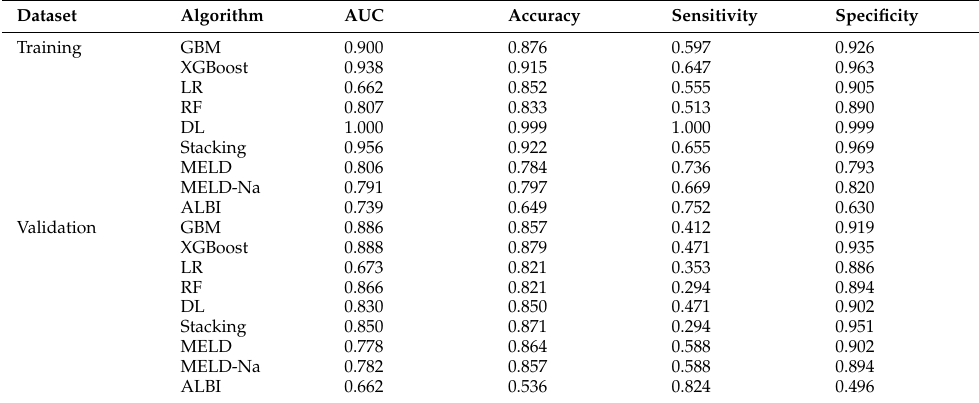
Table 2. Performance of the AutoML models and the existing scoring systems in predicting mortality in patients with non-cholestatic cirrhosis.